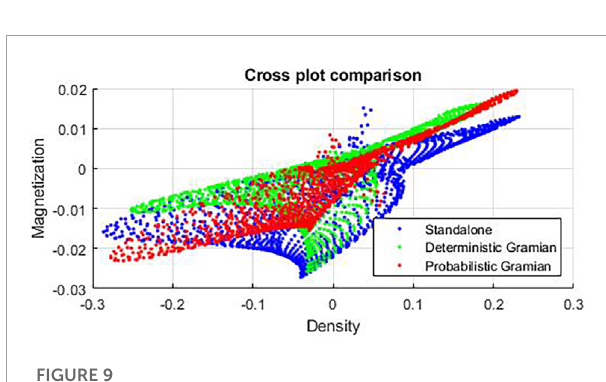
FIGURE 9 Cross plots of the density and magnetization values surrounding the Uranus diapir. The blue dots represent the correlation from the standalone inversions. The green and red dots represent the correlation from the deterministic and probabilistic Gramian inversions,